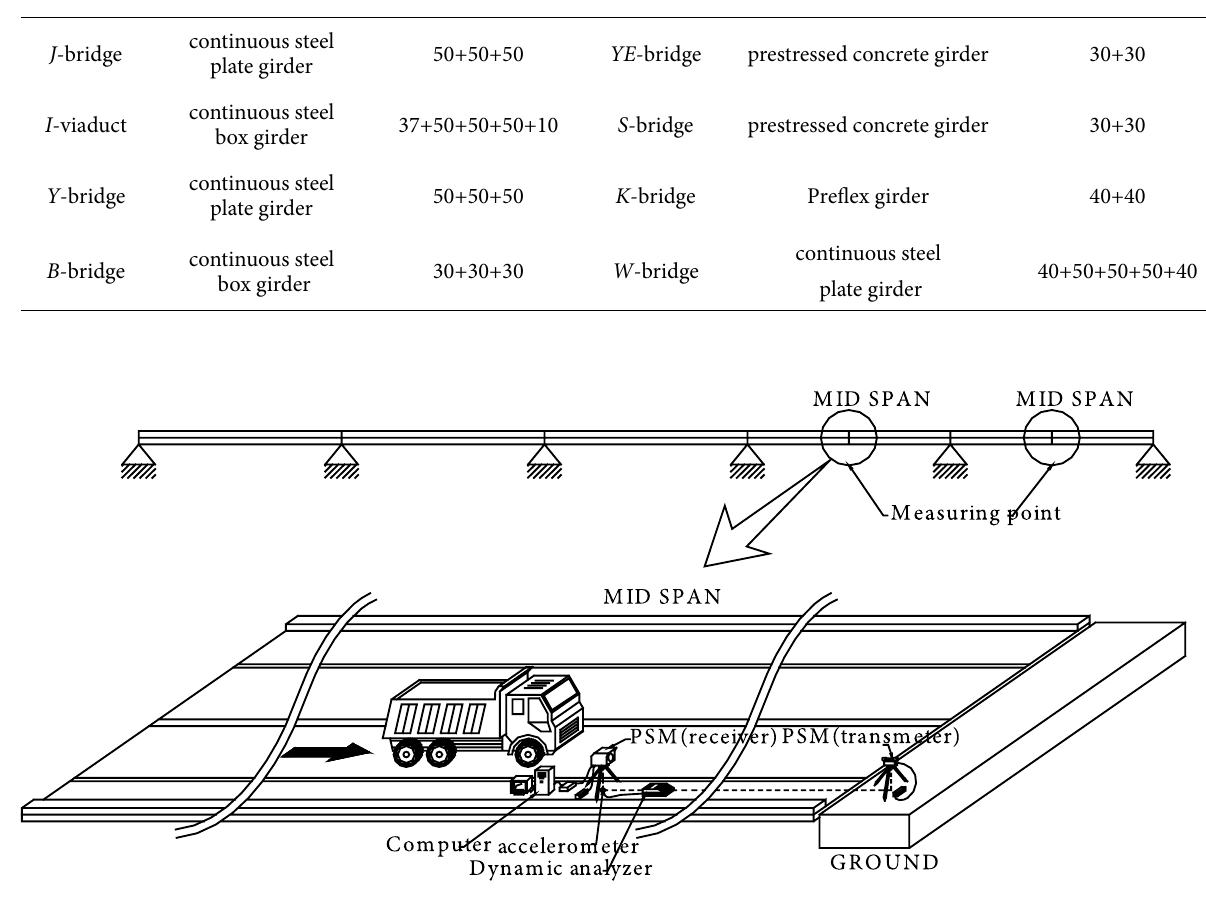
Fig. 4. Examples of measuring point